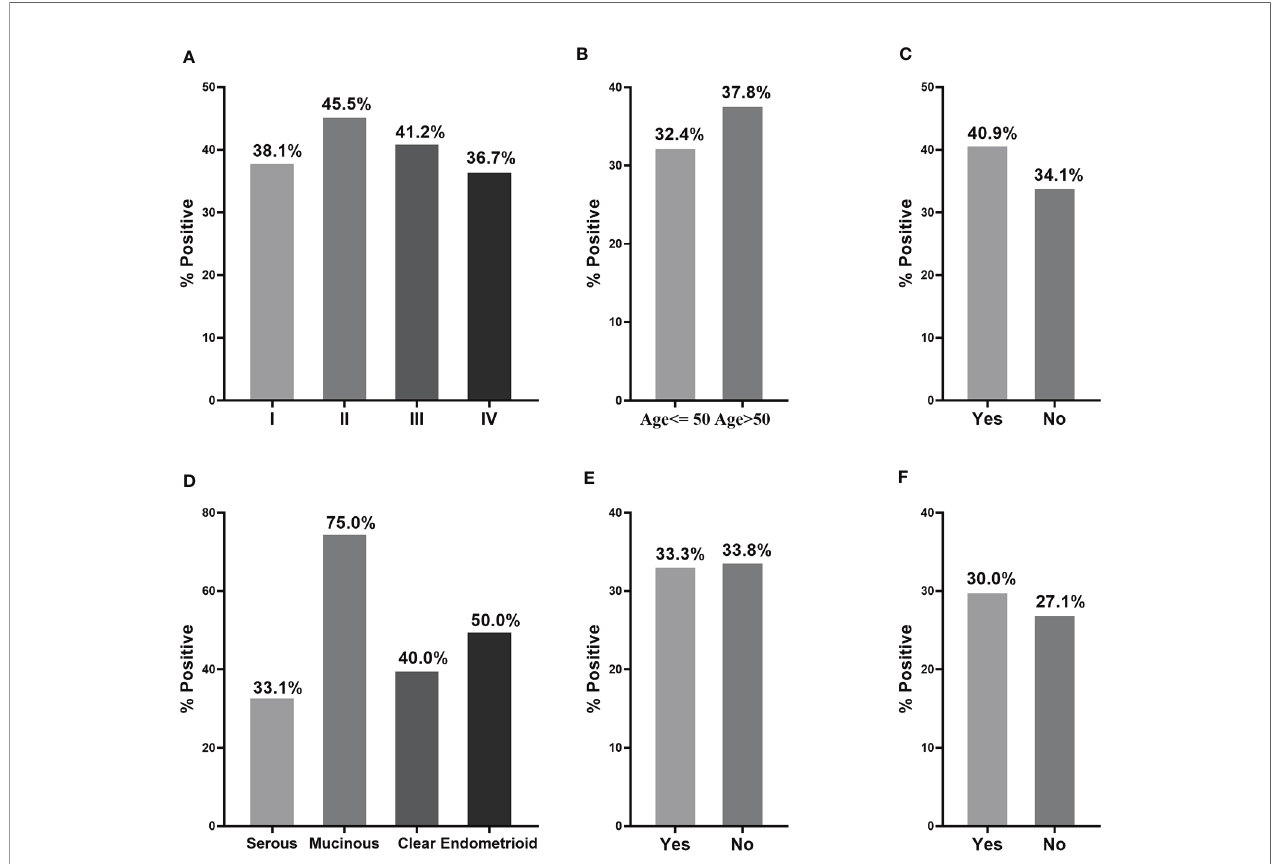
FIGURE 4 | The performance of anti-PDLIM1 AAb in different subgroups of OC patients. The frequency of anti-PDLIM1 AAb among subgroups of OC patients based on stage (A) , age (B) , family tumor history (C) , histological type (D) , lymph node metastasis (E) , and distant metastasis (F)